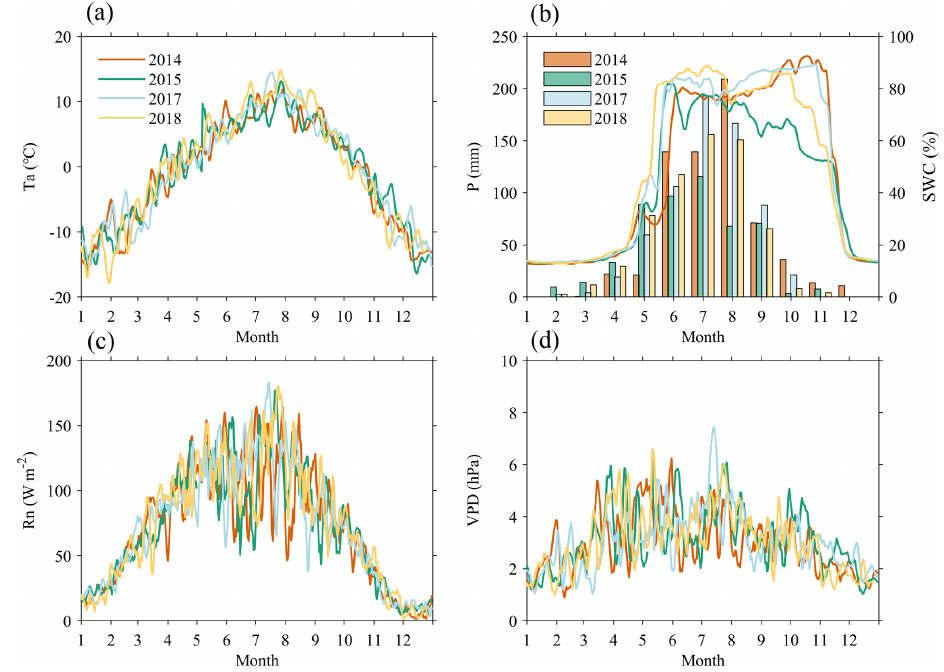
Figure 2. Five-day moving average meteorological variables (Ta, P , SWC, Rn, and VPD) in the studied swamp alpine meadow.